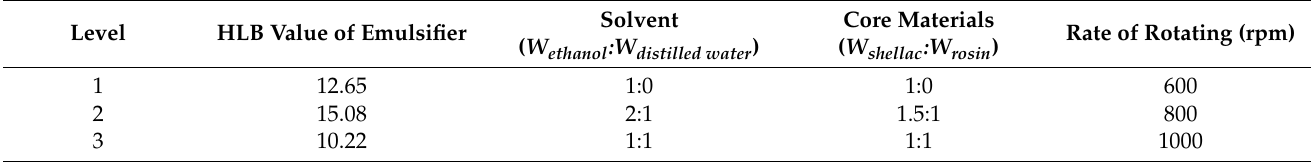
Table 2. The factors and levels of the orthogonal